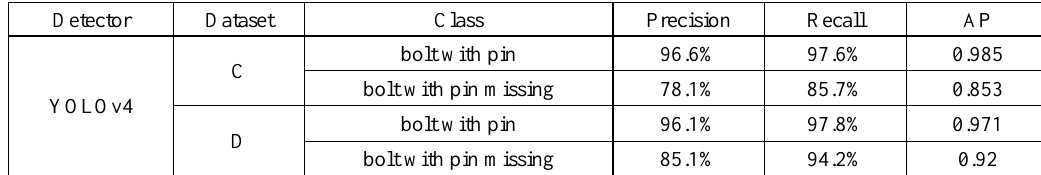
Table 2 . Comparison of the detection results of bolts with pins and bolts with pins missing in datasets C and D.